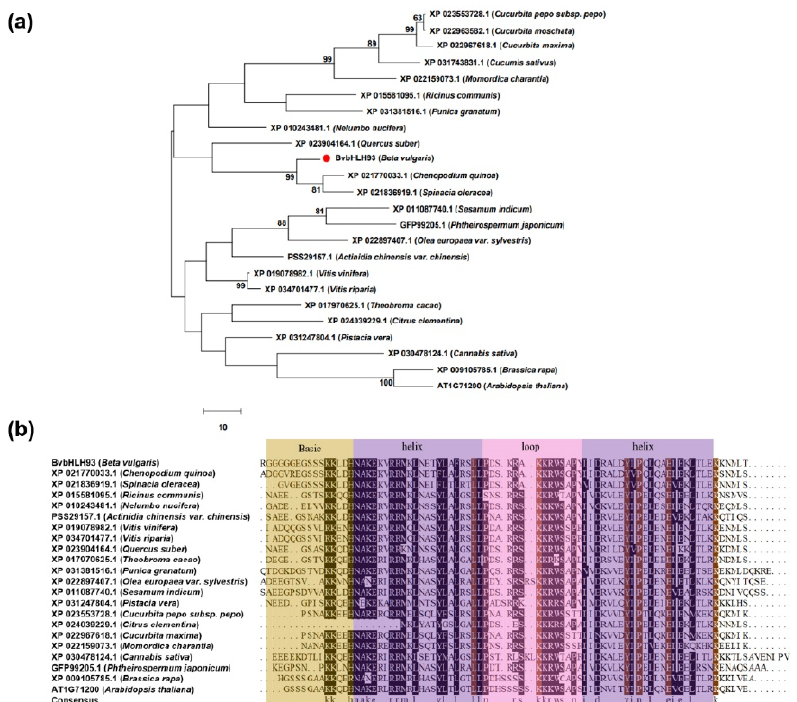
Figure 1. Phylogenetic relationship and sequence alignment of the BvbHLH93 and its orthologs from other plants. ( a ) The phylogenetic tree was based on the full-length protein sequences of BvbHLH93 and its orthologs from other plants. ( b ) Sequence alignment of the deduced amino acid sequences of BvbHLH93 and its orthologs from other